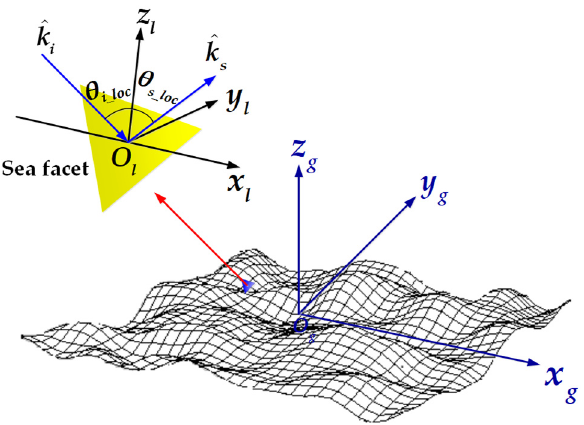
where ˆ n is the normal vector of a sea facet.